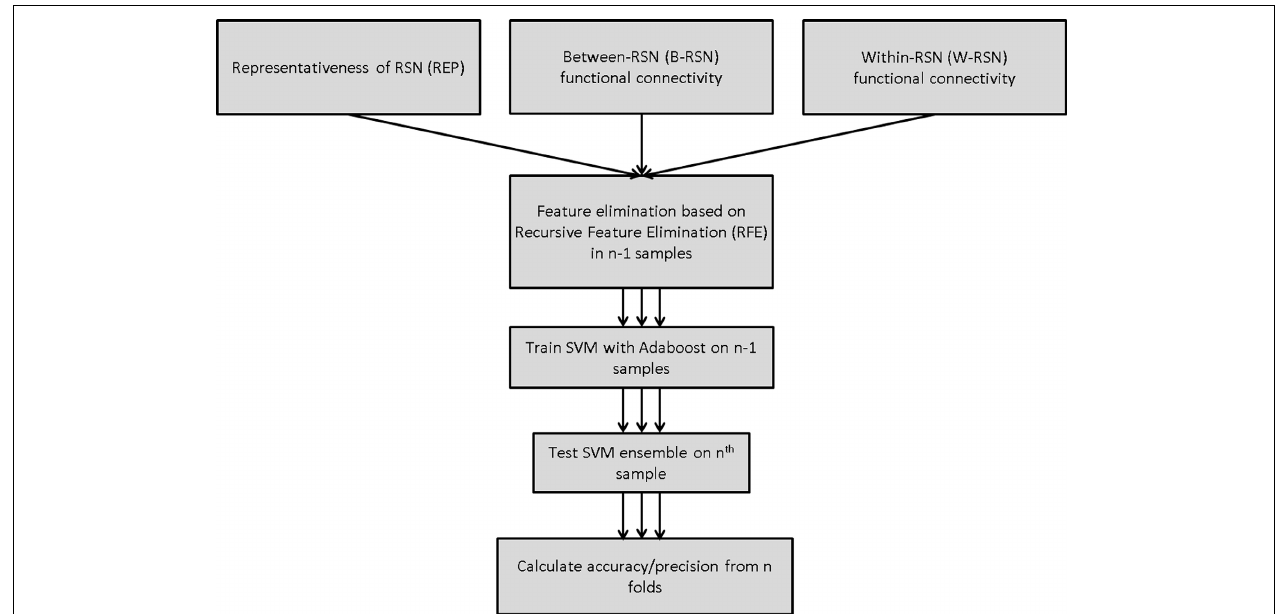
FIGURE 2 | Classification algorithm for predicting smoking status using